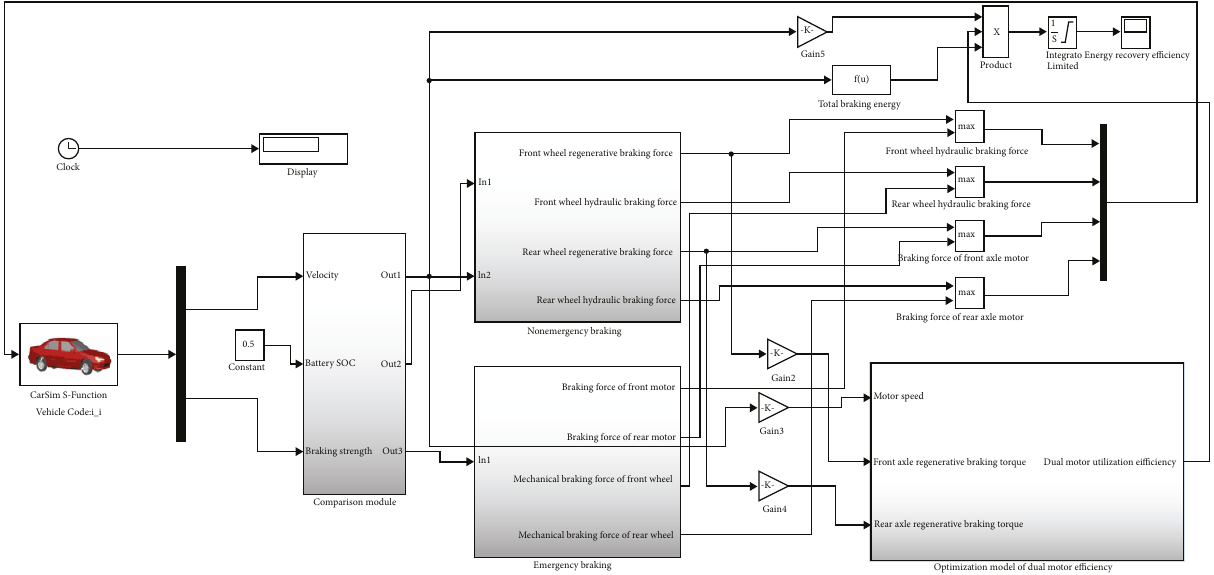
Figure 4: Regenerative braking simulation mode.